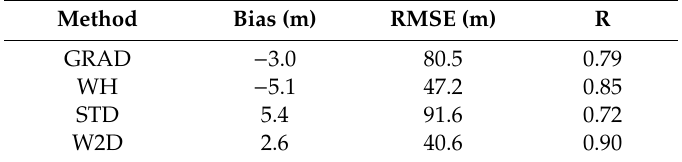
Table 8. Comparison of the ML height (m) determined by di ff erent methods with the radiosonde results. Method Bias